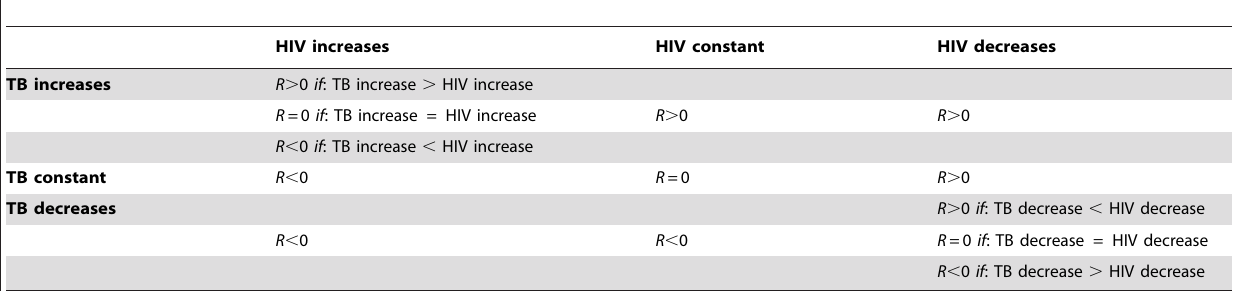
Table 1. Value of R TB/HIV ( R in the table) as determined by the relative rates of the TB and HIV epidemics.